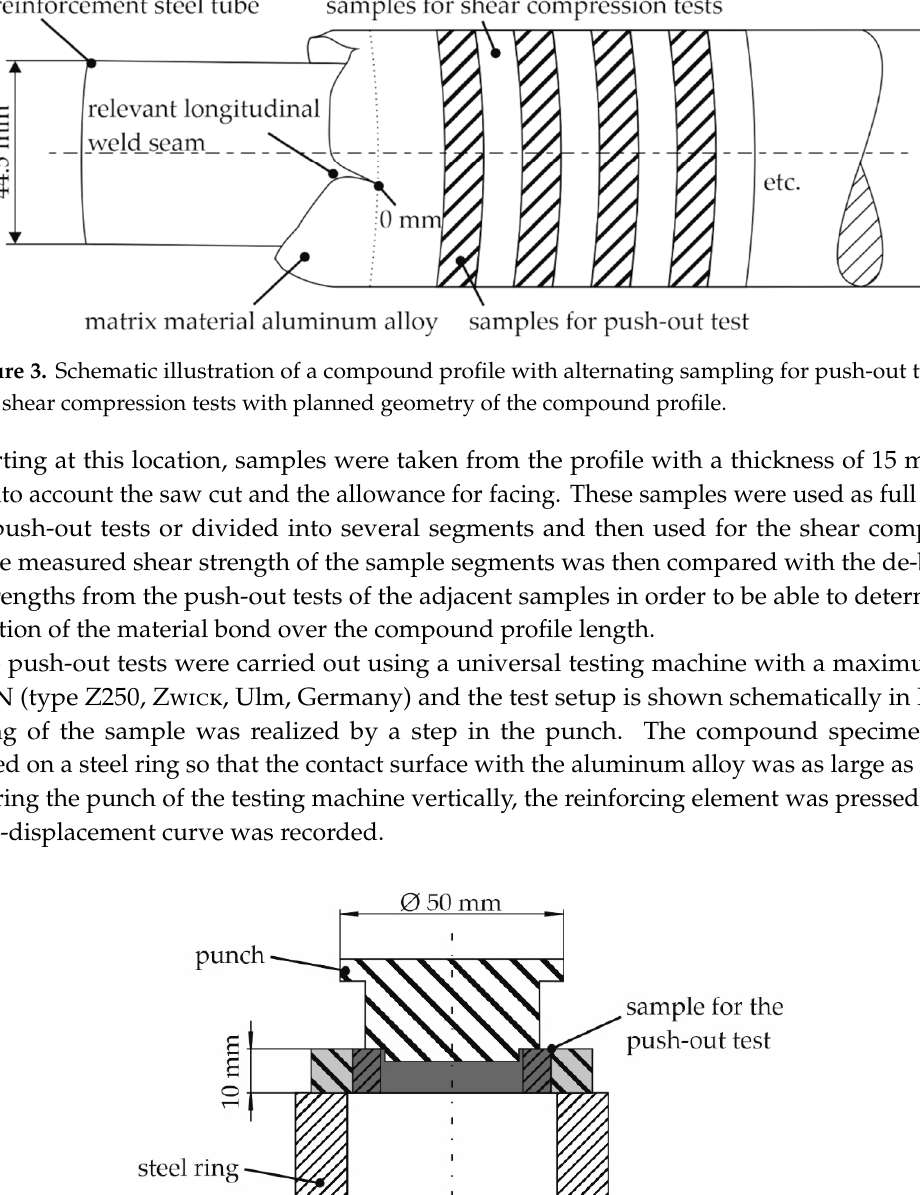
Figure 4. Schematic illustration of the experimental setup of the push-out tests using a sample taken from a hollow compound profile.